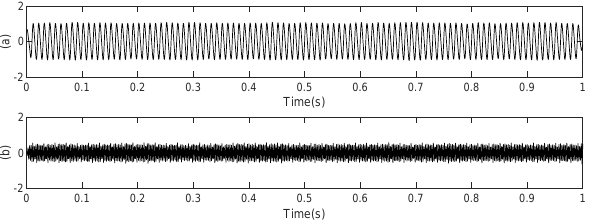
Figure 4. The IMF components 1–2 ( a , b ) of the mixed signal after VMD when [K, α ] = [2, 1000]. The parameters [ K , α ] in the VMD method are optimized by using the WOA. The mixed signal is decomposed by VMD using the optimized parameters. The decomposition results are shown in Figure 5. After 15 iterations, the optimal parameters were obtained, and [ K , α ] = [4, 3319] was set. The corresponding relationship after decomposition is: IMF1–4 correspond to signals 1–4, respectively. The IMFs is less affected by noise, and the performance of VMD is improved.